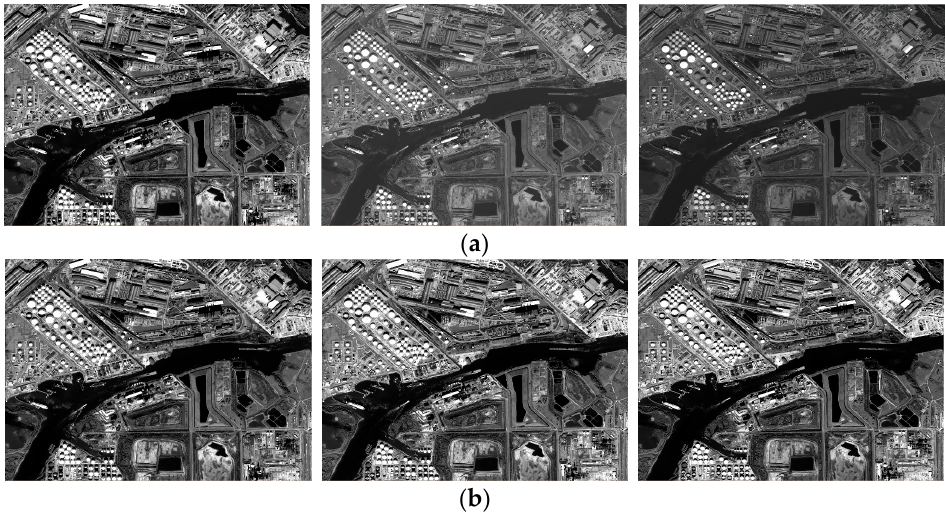
Figure 5. The experimental results of histogram matching: ( a ) Sequence images of before histogram matching; ( b ) Sequence images of after histogram matching.